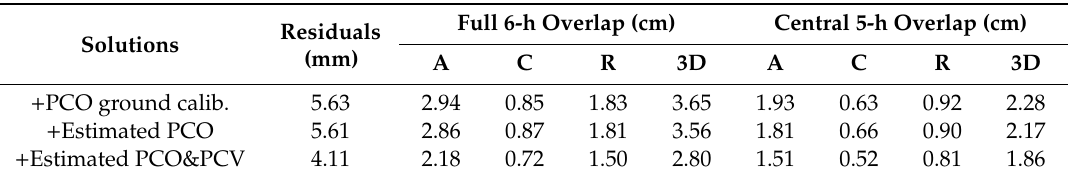
+ PCO ground calib.